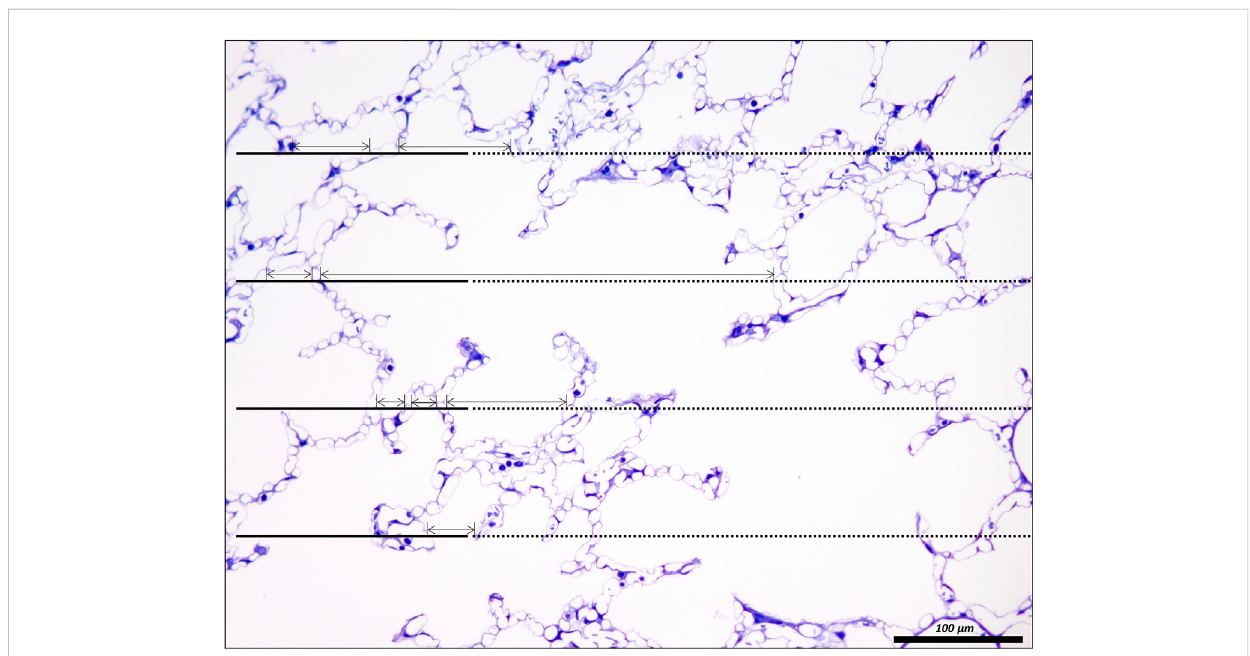
FIGURE 5 Unbiased test-system for measurements of chord length of acinar air spaces. A healthy rat lung was fi xed in vivo by vascular perfusion via the vena cava caudalis at an airway opening pressure of 5 cmH 2 O on expiration after two recruitment maneuvers (3 s pause at 30 cmH 2 O) (Knudsen et al., 2018). The parameter “ chord length ” is also known as the linear intercept length. It is based on simple, linear measurements of the dimension of the acinar airspaces from one border to the next. The left side of the randomly sampled image contains four straight line-segments, extended to the right by a dashed line, the so-called guard line. The line segments on the left serve to sample the starting point of the measurements. Each time the line segment intersects an interalveolar septum a measurement is performed from the intersection to the next surface of an interalveolar septum. The direction of the measurement follows the run of the test line and if needed also the dashed guard line. In order to locate the points of measurements exactly the top border of the line segment is used. The arrows label the measurements in this example. Some measurements are performed within an alveolus, others, however, travers via the alveolar opening through the alveolar duct airspace to the other side so that these measurements encompass both alveolar and alveolar duct